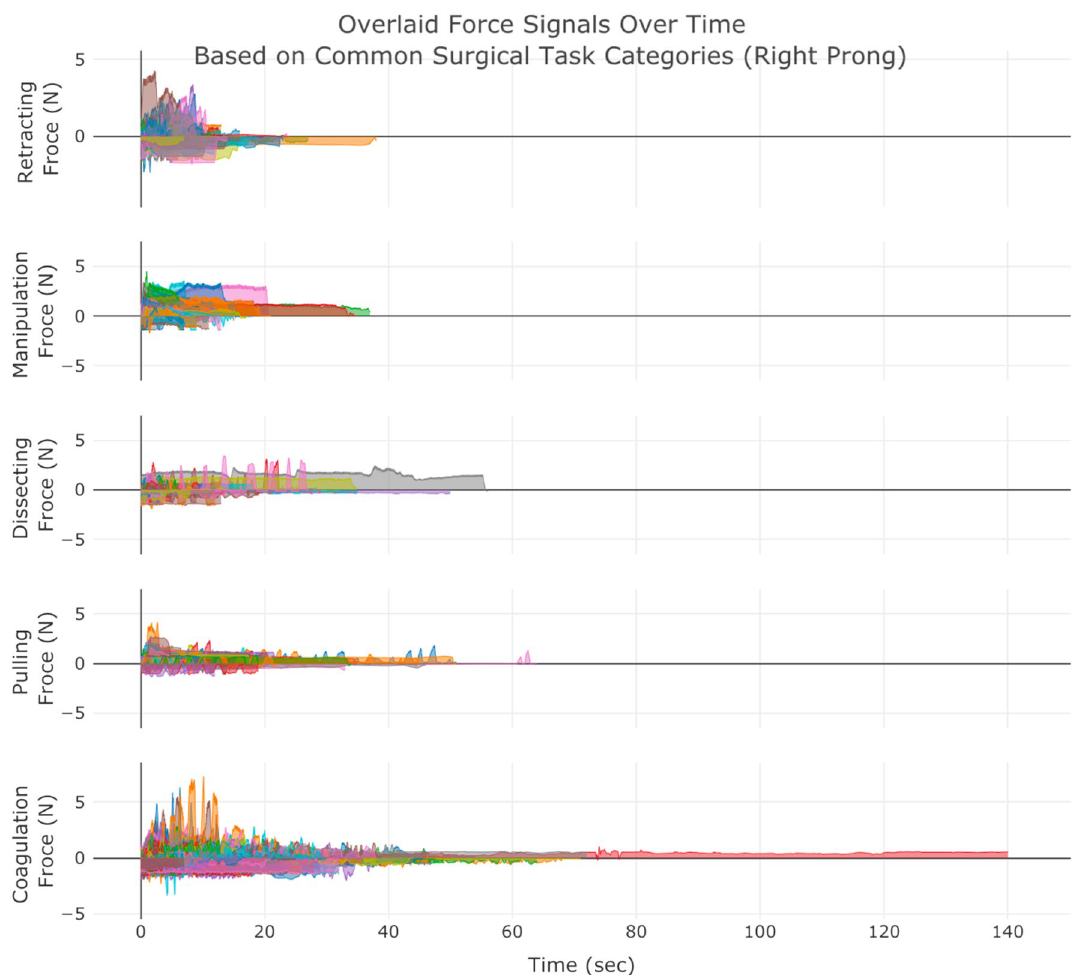
Figure 1. SmartForceps timeseries data of the Right prong across the 5 surgical tasks of Retracting, Manipulation, Dissecting, Pulling, and Coagulation overlaid for 50 cases. Differences in the range and duration of force are shown in the overlaid data profiles. Please refer to our Supplementary Materials for both left and right prong data. These charts have fully interactive capability including zoom, pan, download, etc. Figure created by R Plotly library version 2.0: https:// plotly.